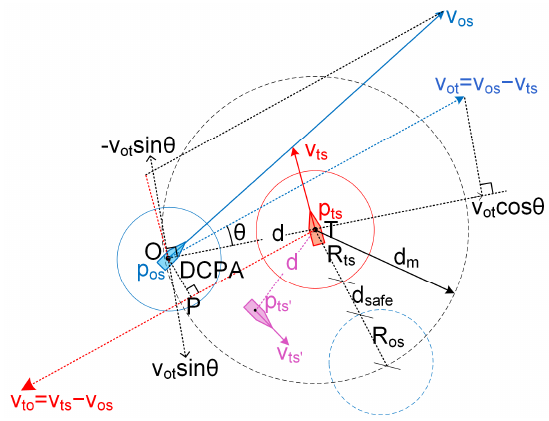
Figure 8. The vectors and CA strategy for emergency ship-to-ship encounters; distance to the closest point of approach (DCPA).